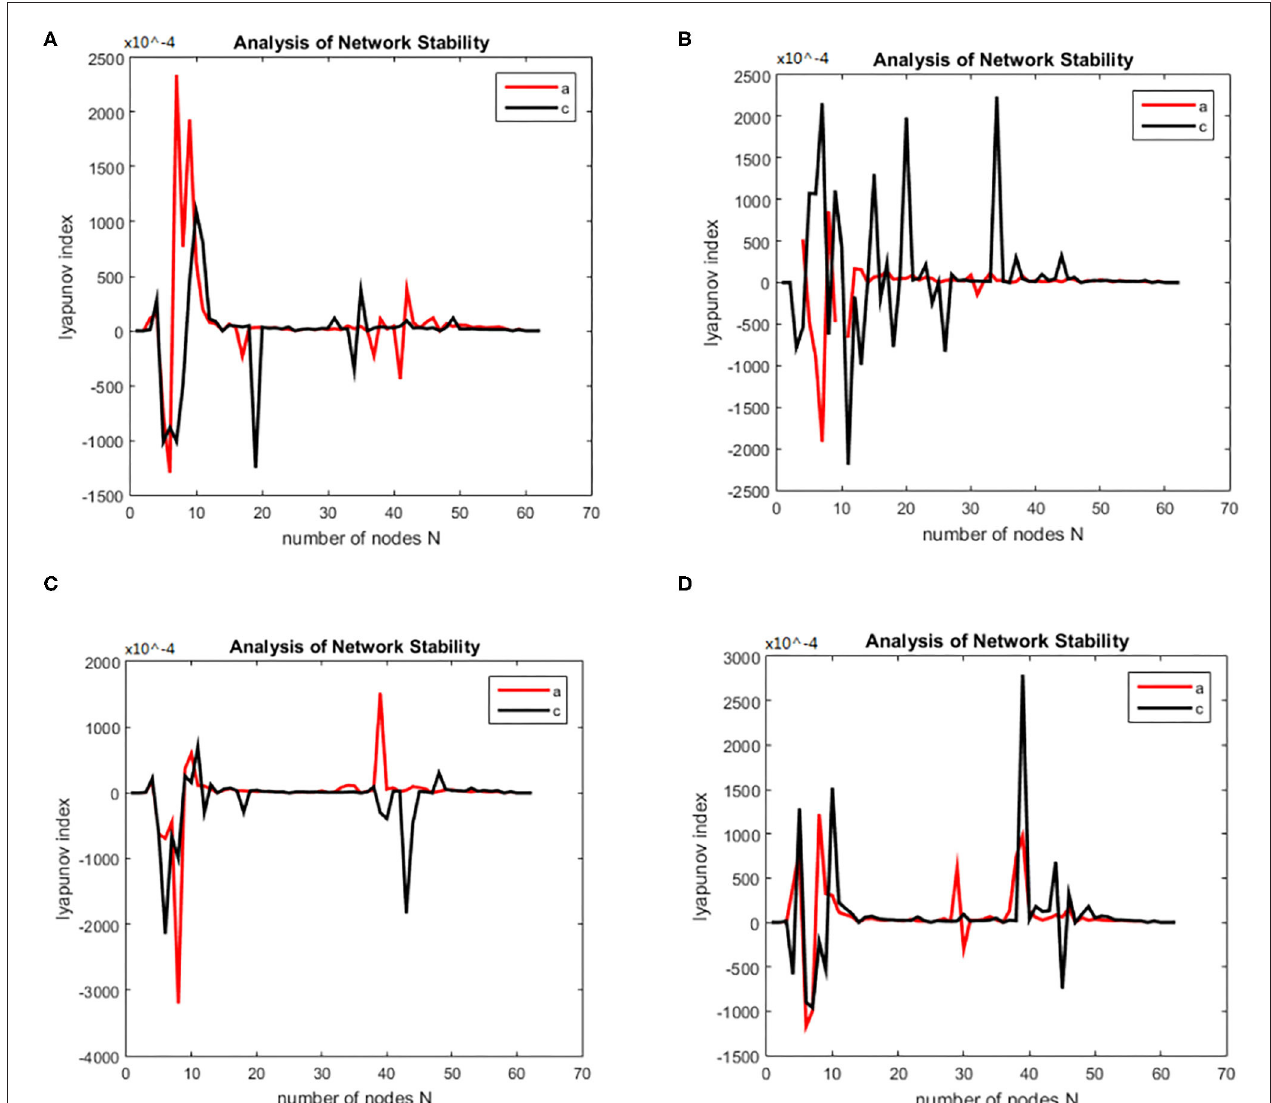
FIGURE 2 | Bain network synchronization experimental results for different subjects in the alcoholic data set under the same connection density (40%). (A) Alcoholic subject number is co2a0000405, normal subject number is co2c0000357, (B) Alcoholic subject number is co2a0000417, normal subject number is co2c0000367, (C) Alcoholic subject number is co2a0000418, normal subject number is co2c0000370, (D) Alcoholic subject number is co2a0000451, normal subject number is